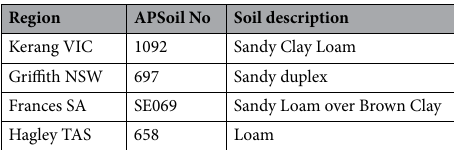
Table 3. APSIM soil numbers and soi descriptions for each